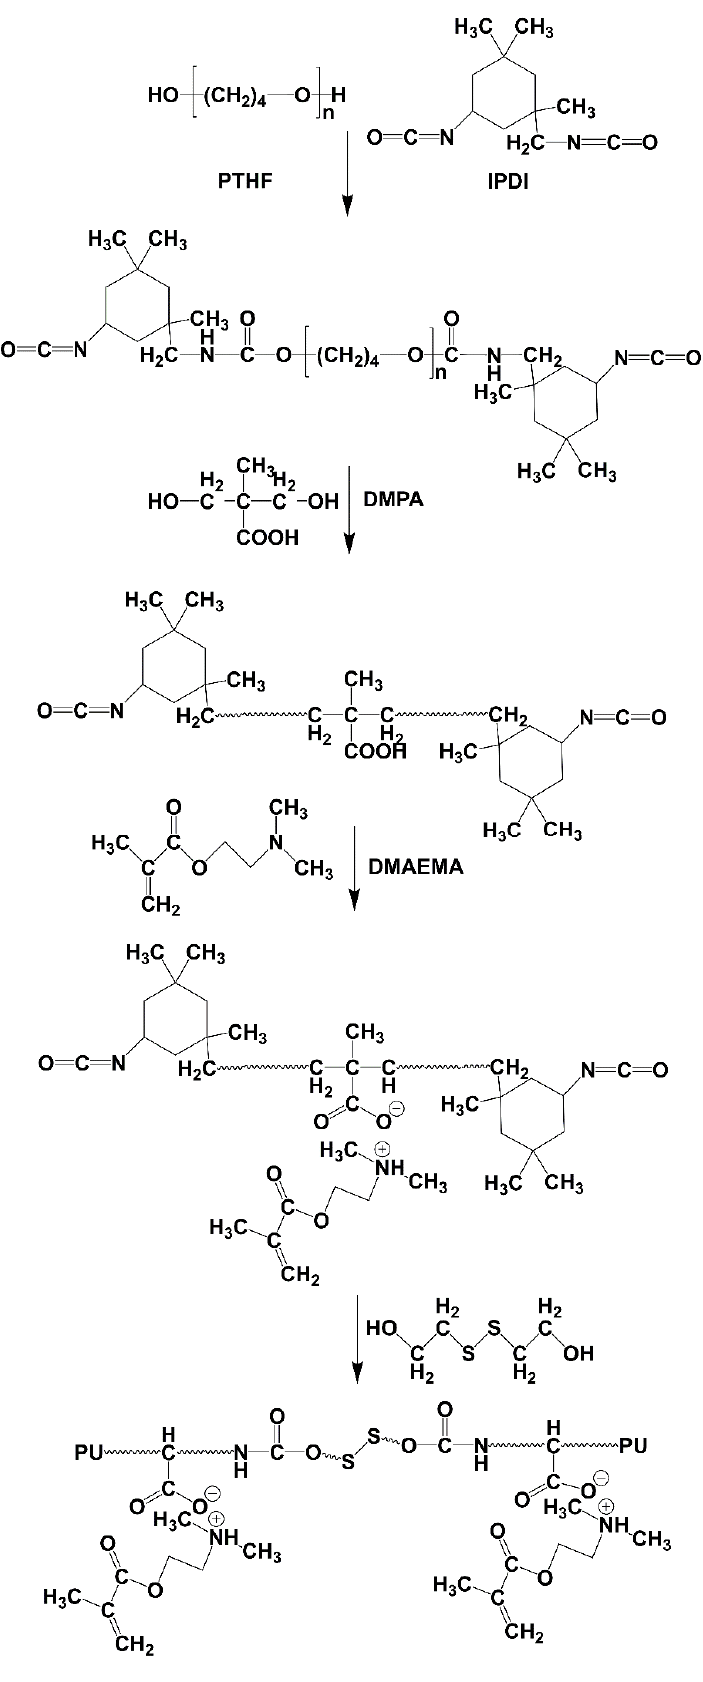
Figure 1. Preparation process of MFWPU prepolymer.